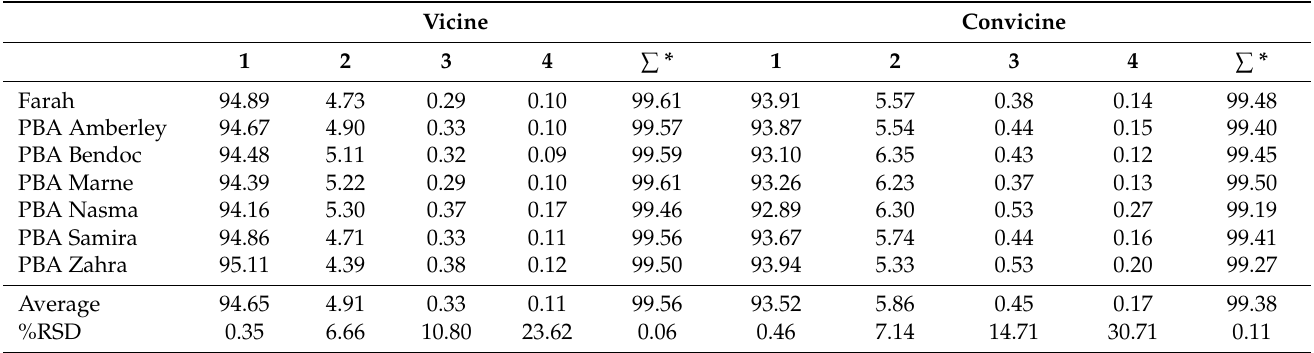
Table 1. Summary of the extraction optimisation data from four consecutive extractions of the one sample and the sum of extracts 1 and 2 ( ∑ ).